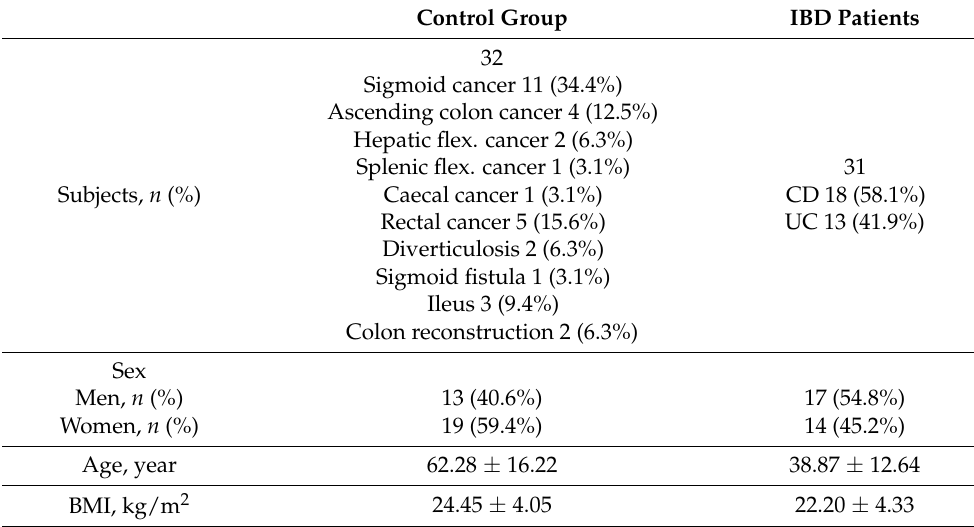
Table 1. Socio-demographic data of inflammatory bowel disease (IBD) patients and controls.